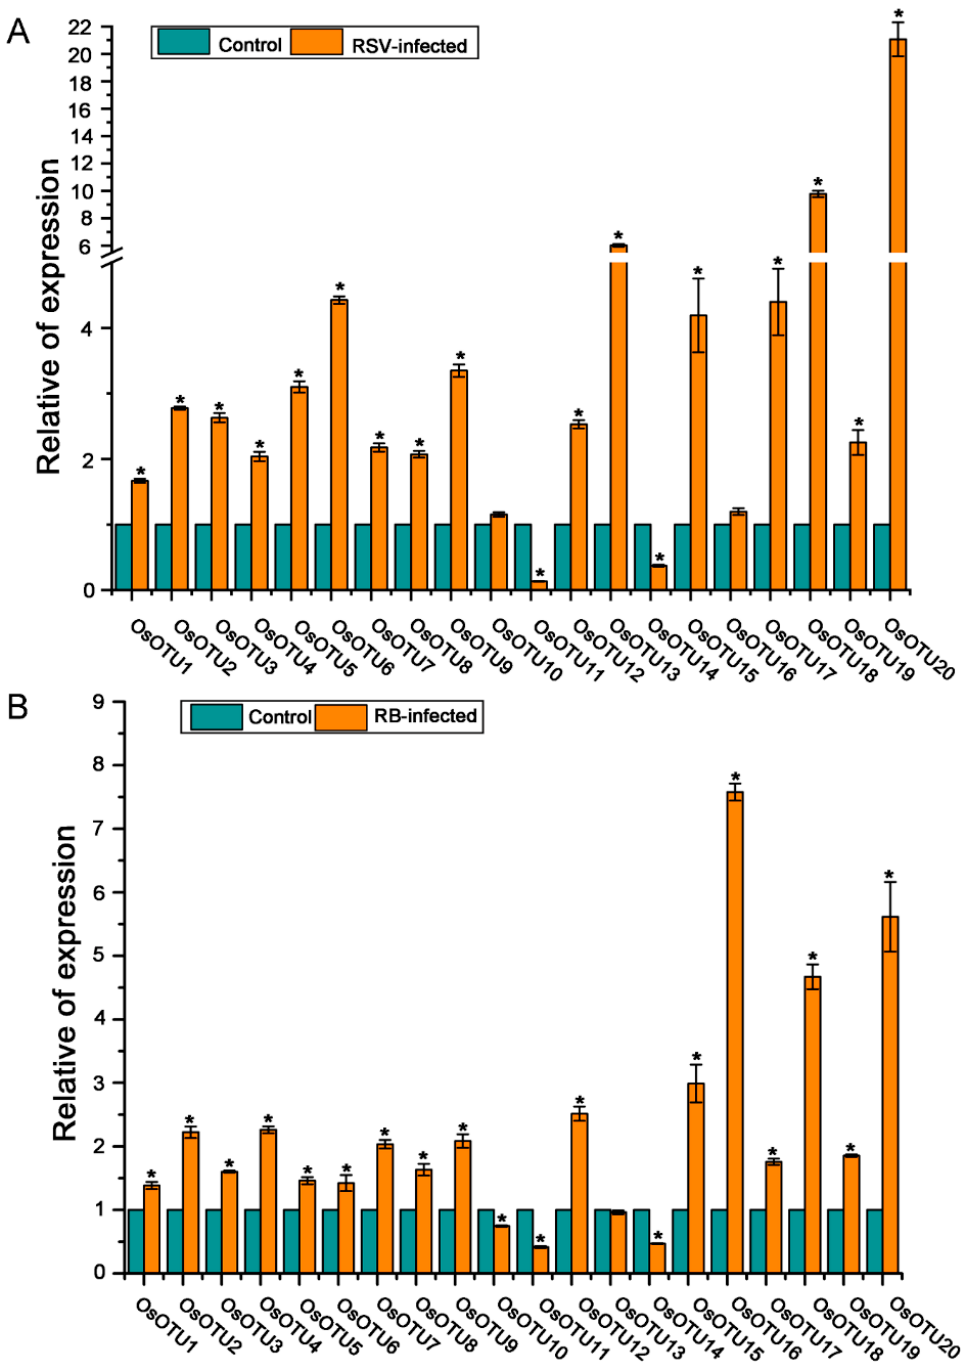
Figure 8. The expression of OsOTU genes in response to RSV ( A ) and RBSDV ( B ) infection. Three biological replicate experiments were performed for each treatment and gene expression was detected by RT-qPCR. Samples were collected at 25 days post-inoculation (dpi) from RSV-infected plants and at 45 dpi from RBSDV-infected plants. The OsUBQ5 gene was used to normalize the relative gene expression. Error bars represent ± SE ( n = 3). * indicates significant differences from the mock control at p ≤ 0.05 by Fisher’s least significant difference tests.